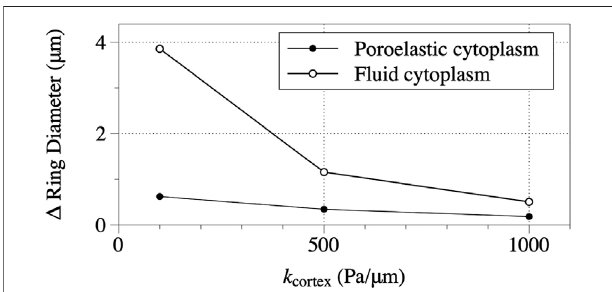
FIGURE 7 | Steady state change in bleb ring diameter for simulations with the fl uid cytoplasm model and poroelastic cytoplasm model. Change in bleb ringdiameterisde fi ned asbleb ringdiameterminusthesteadystatebleb ringdiameterforsimulationswhereblebswereinitiated byremovingonly membrane-cortex adhesion. The bleb ring diameter for the fl uid cytoplasm simulation where a bleb is initated by removing only membrane-cortex adhesion is 0.75 μ m. The corresponding value for the poroelastic cytoplasm simulation is 0.97 μ m. The parameters for the simulations are the same as described in the caption for Figure 6